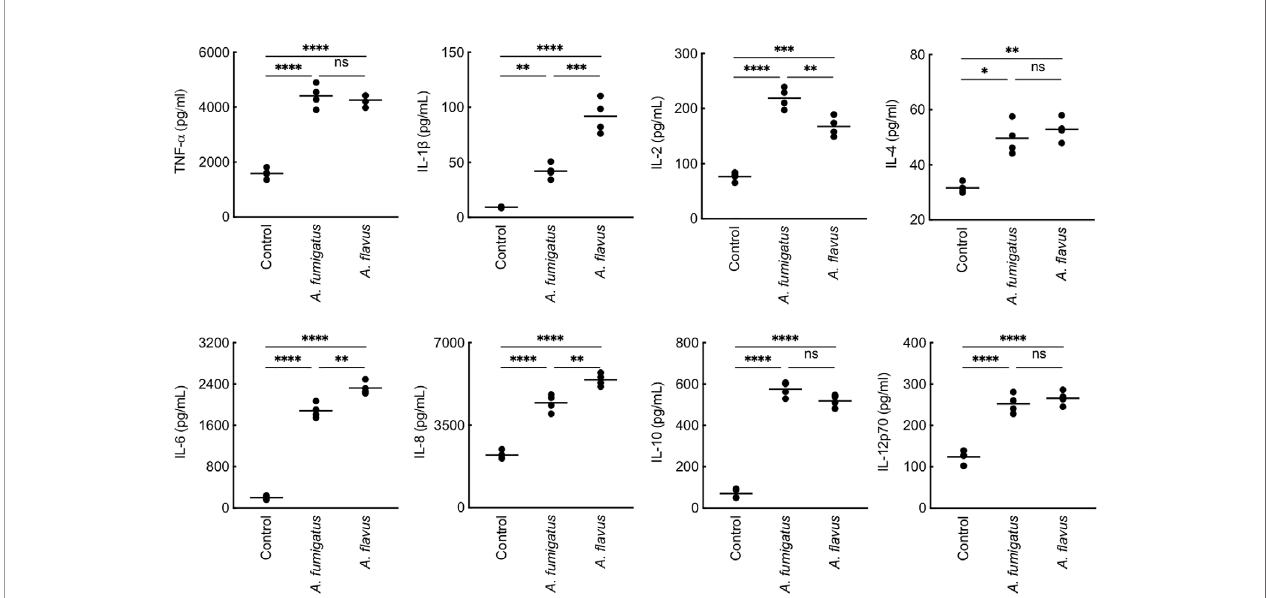
FIGURE 3 | Cytokine induction in human monocyte-derived macrophages (MDMs) by metabolically active conidia. Human MDMs [obtained by seeding 2x10 6 peripheral blood mononuclear cells (PBMCs) per well] of four healthy donors were co-incubated with metabolically active (live) conidia (5x10 5 per well) in RPMI (37°C, 20 h), and the supernatants were collected for cytokine quanti fi cation. Both A. fumigatus and A. fl avus stimulated the cytokine secretion by MDMs. A. fumigatus live conidia stimulated a signi fi cantly higher level of IL-2 compared to A. fl avus , while A. fl avus stimulated higher secretion of IL-1 b and IL-6 (ns – not signi fi cant, *p < 0.05, **p < 0.01, ***p < 0.005 and ****p <